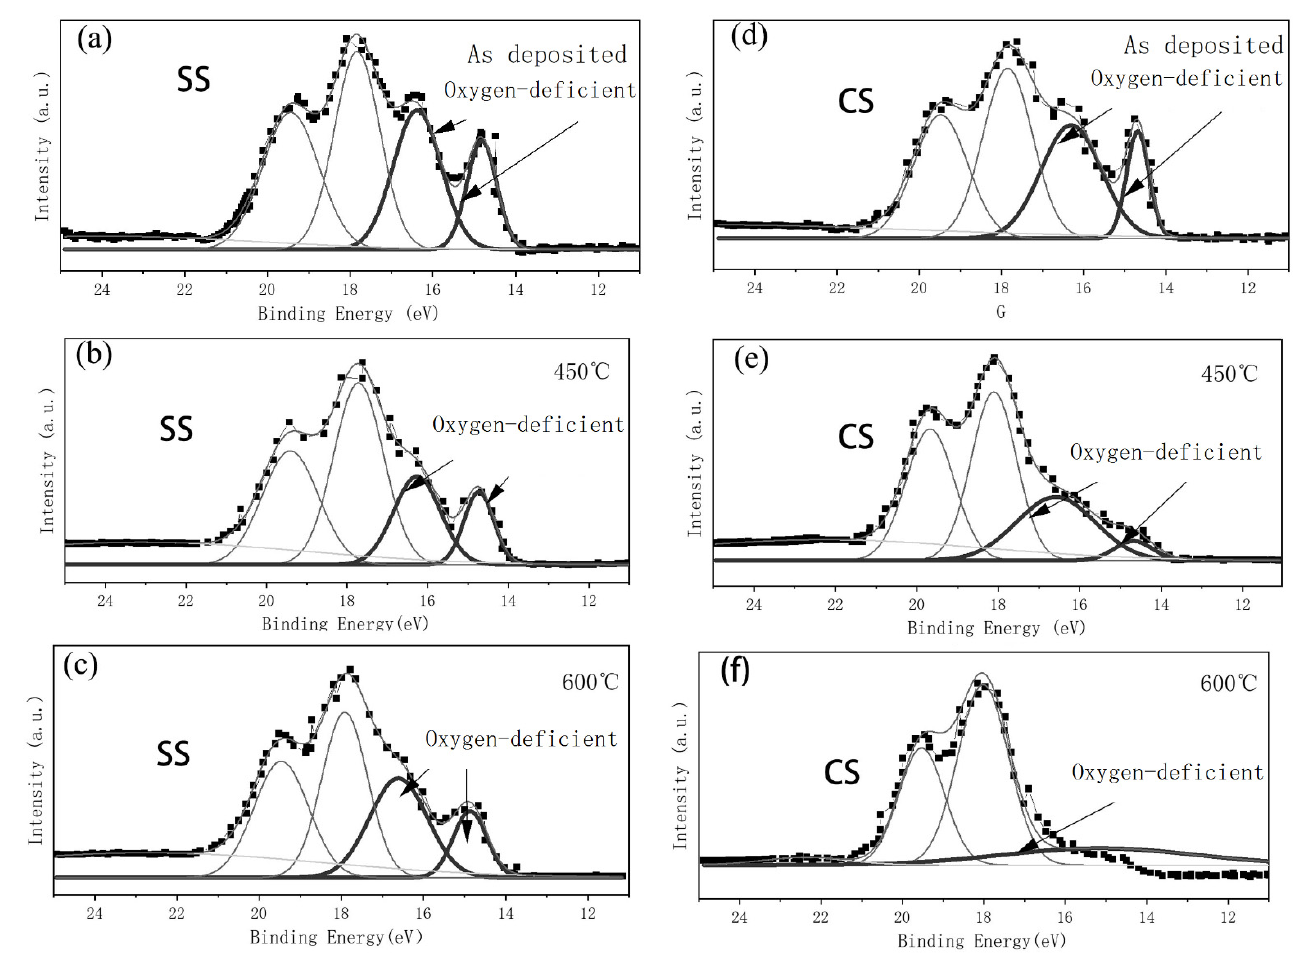
Figure 4. Hf 4 f spectra of ( a ) as deposited SS, ( b ) 450 °C-RTP treated SS, ( c ) 600 °C-RTP treated SS, ( d ) asdeposited CS, ( e ) 450 °C-RTP treated CS and ( f ) 450 °C-RTP treated CS samples, respectively.